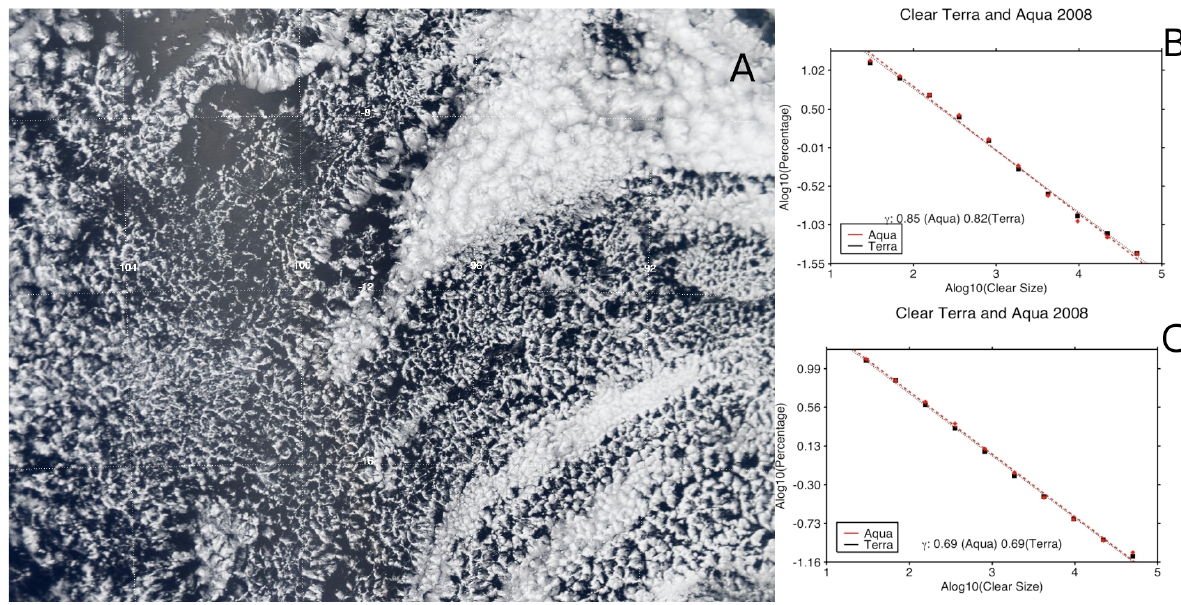
Fig. 4. (A) A visible MODIS image showing a stratocumulus deck breaking up. Open cell convections dominate the scene. It is over the Southern Pacific. (B) Clear sky size distributions for September 2008 over the South Pacific open cell region (Wood and Hartmann, 2006). Both Aqua and Terra data are shown. (C) same as (B) but for open cell clouds over North Pacific (Wood and Hartmann,